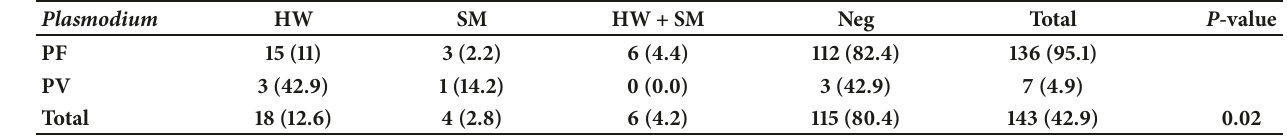
Table 3: Distribution of helminths in plasmodium infected school age children in Northwest Ethiopia, 2016. Plasmodium